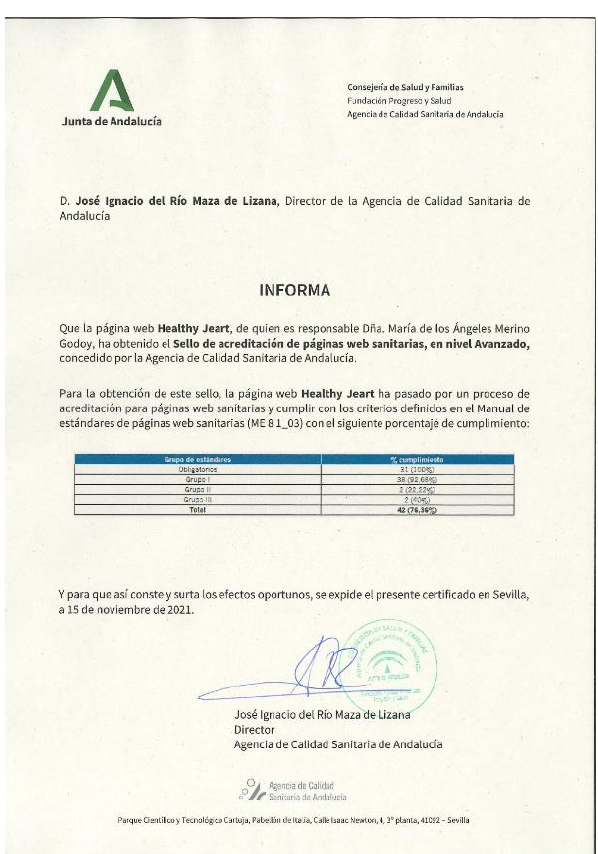
Figure A2. Advanced Level Accreditation for Web Pages.